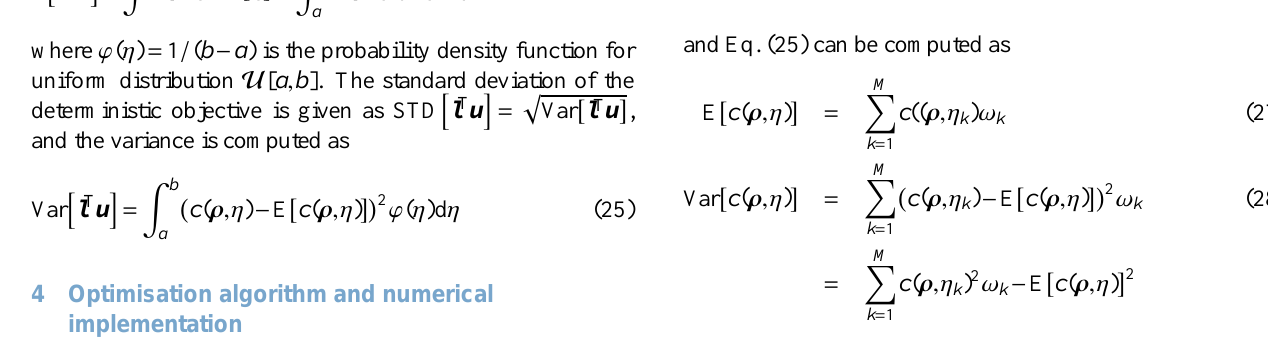
Figure 1. Design domains and boundary conditions for a compliant inverter design.